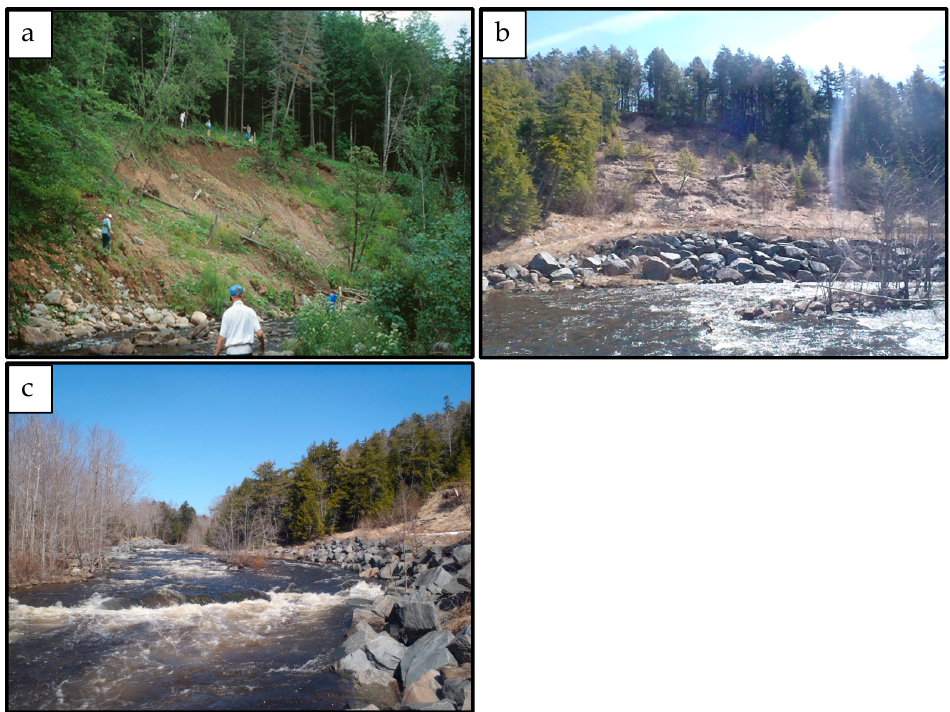
Figure 3. Sediment site rehabilitation: ( a ) pre-restoration site condition; ( b ) post-restoration site condition; and ( c ) post-restoration looking upstream at river channel gradient control structure